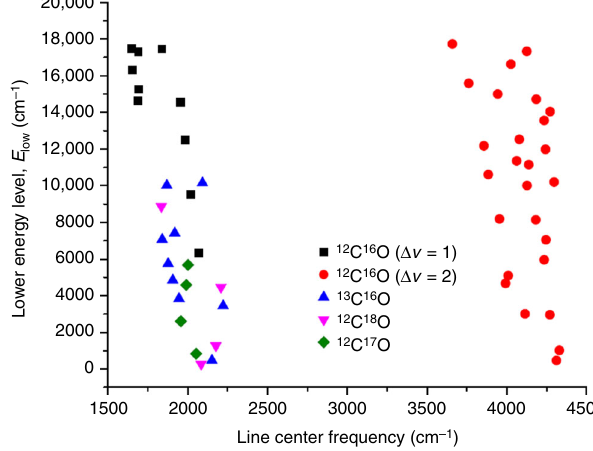
Fig. 1 Lower energy levels versus line center frequency for co-added lines. Lines are constructed from ATMOS FTS data for all CO isotopologues analyzed 12 . The lower energy level is the energy of the lower state for a given transition. Most co-added lines consist of 3 – 6 individual lines of similar lower energy level and line center frequency. Overtone lines ( Δ v = 2, where v is the vibrational level) are used only for 12 C 16 O. Analyses of rare isotopologues use only the fundamental transitions ( Δ v = 1). Comparison of the 12 C 16 O abundance determined from Δ v = 1 and Δ v = 2 lines is used to make small corrections to the photospheric temperature pro fi